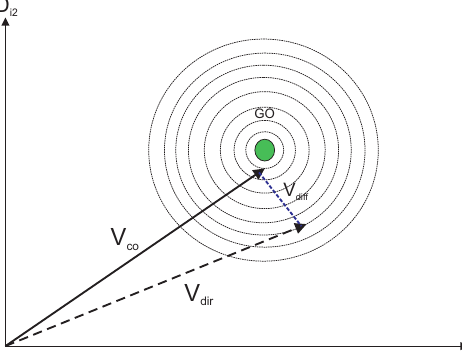
Figure 5. Differential cooperation vector creation.